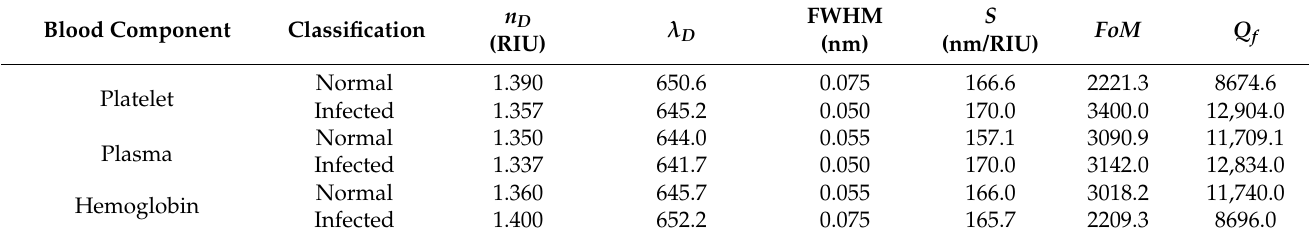
Table 1. The calculated numeric values of S , FoM , and Q f of the proposed 1D biophotonic sensor structure loaded with normal and infected samples containing platelet, plasma, and hemoglobin blood